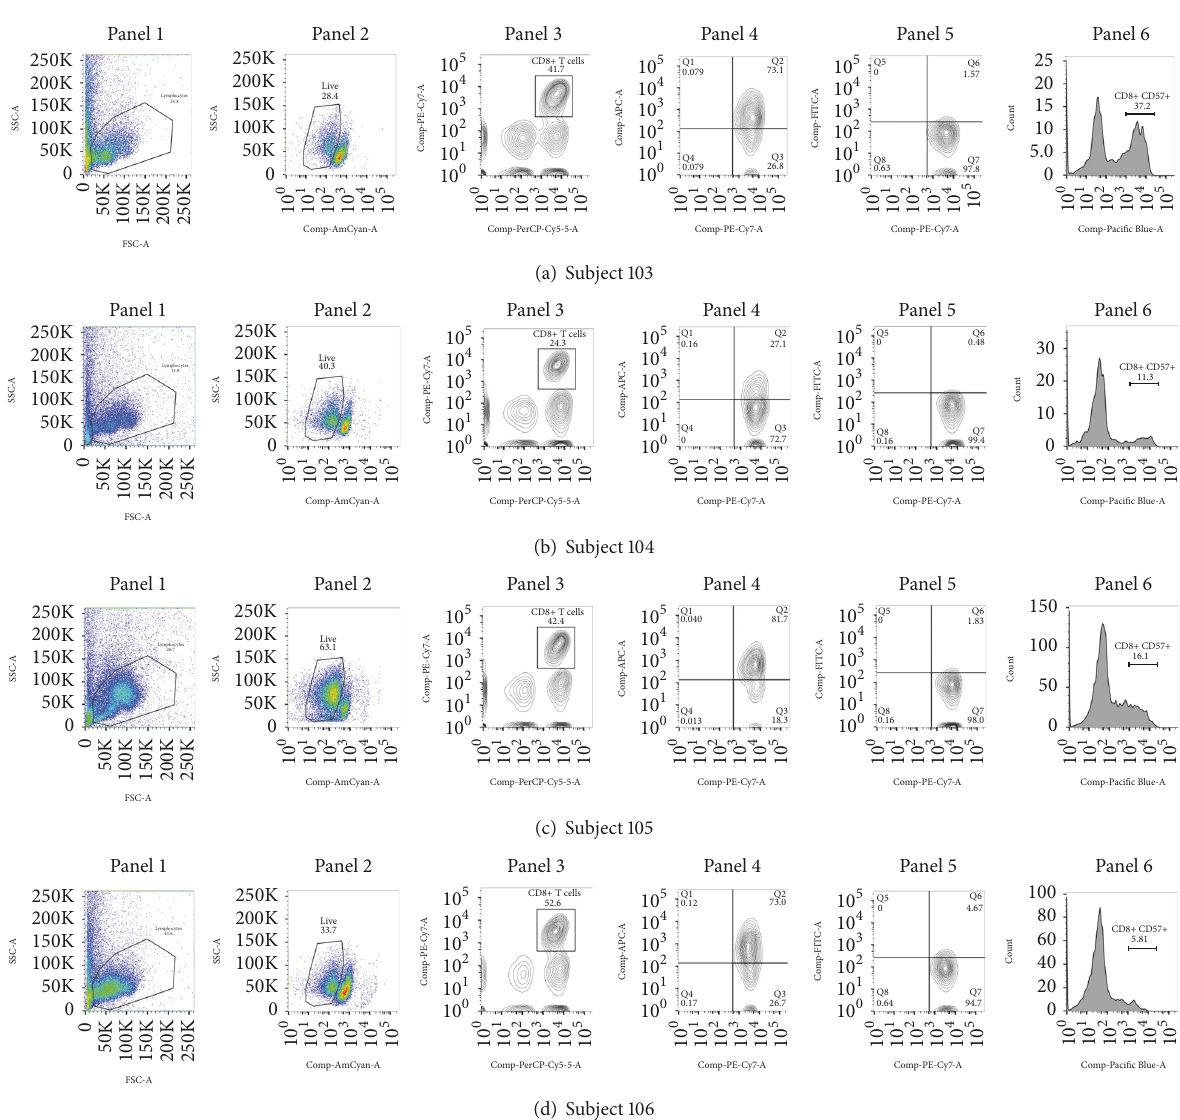
Figure 2: Flow cytometry results for CD8+ T cells. Panel 1: gating of lymphocytes; panel 2: live/dead staining; panel 3: CD3+ CD8+; panel 4: CD8+ HLA-DR+; panel 5: CD8+ CD38+; panel 6: CD8+